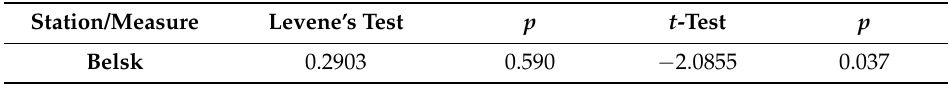
Table 8. Results of the Levene test and t -test together with the right values of probability for Belsk station for 2014.